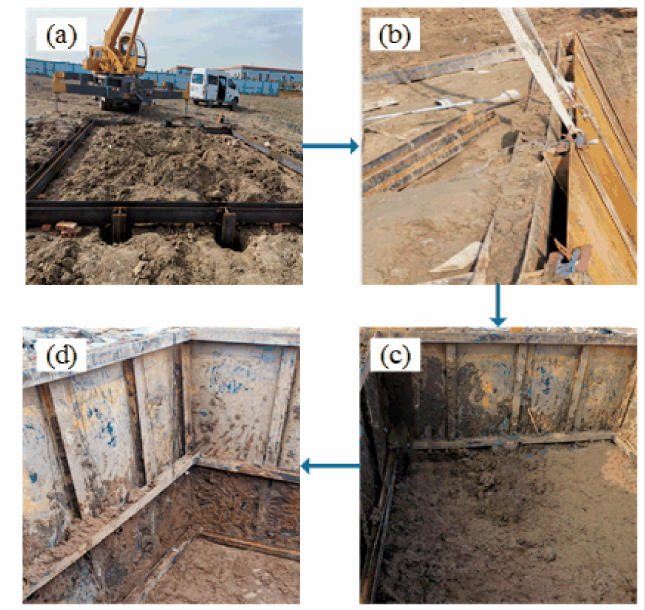
Figure 5. The excavation process of the foundation pit. ( a ) Implantation of the retaining piles and installation of the crown beam; ( b ) Insertion of the rigid panels; ( c ) Excavation of the first layer of the soil and the installation of waist beam 1; ( d ) Excavation of the second layer of the soil and the installation of waist beam